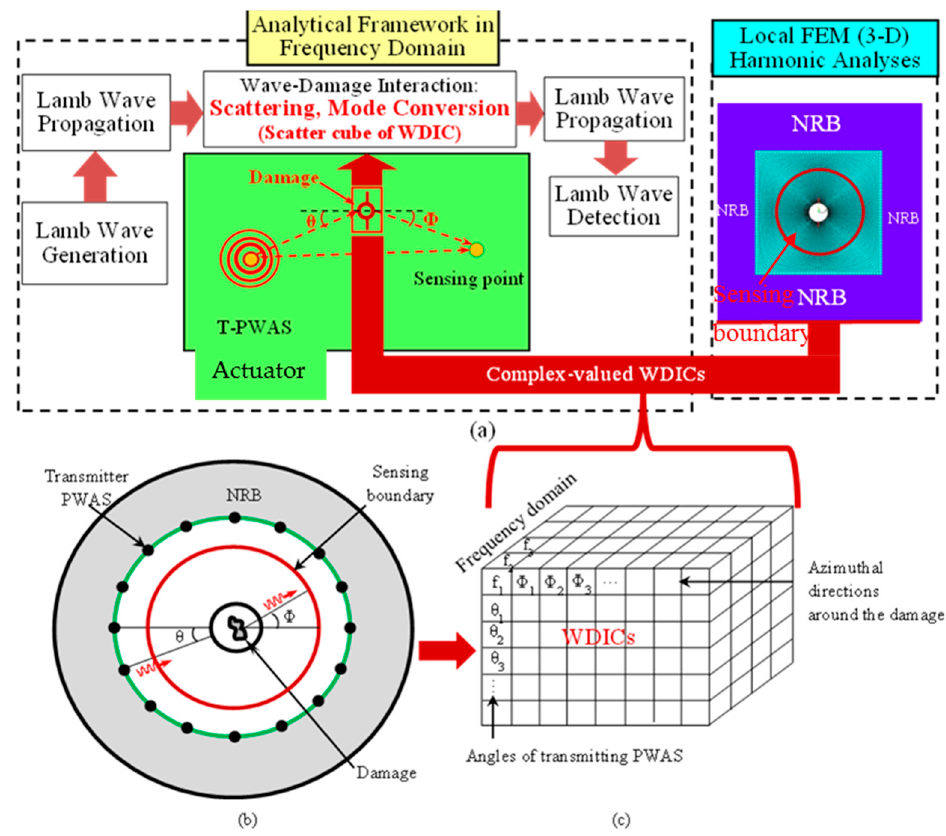
Figure 2. ( a ) Framework of the combined analytical and finite element approach (CAFA); ( b ) Representative model of the damage for FE analysis; ( c ) “Scatter cube” of wave damage interaction coefficient (WDIC).